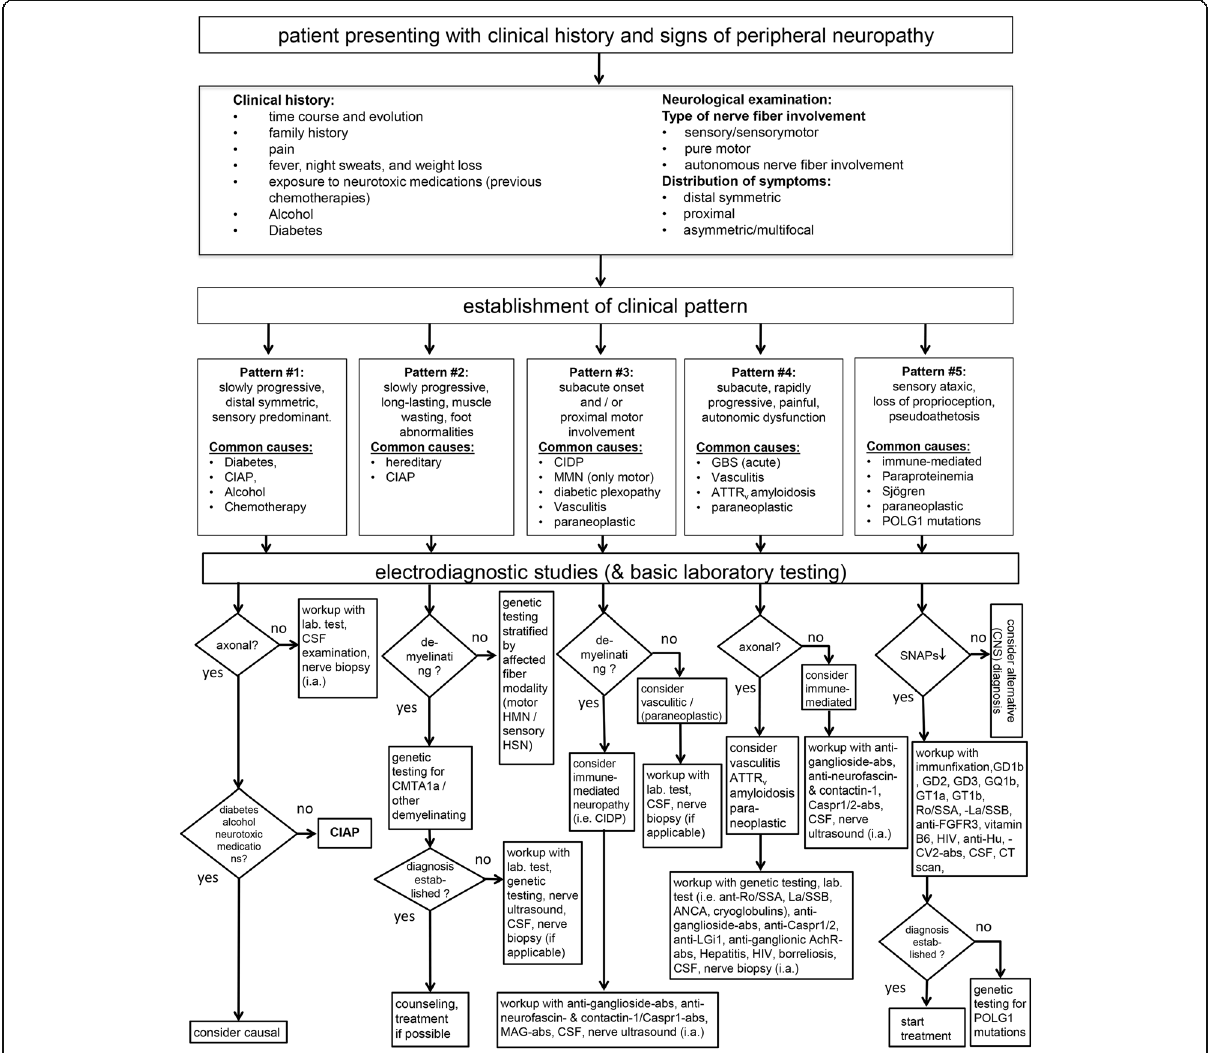
Fig. 1 Flow chart of a diagnostic algorithm for the workup of patients with peripheral neuropathy. According to the established clinical patterns, based on clinical history and examination, diagnostic procedures can be stratified. Abs = antibodies, ATTRv = hereditary transthyretin amyloidosis, CIAP = chronic idiopathic axonal polyneuropathy, CSF = cerebrospinal fluid, i.a.= if applicable, SNAP = sensory nerve action